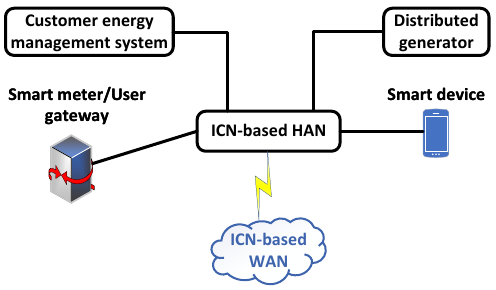
Figure 4. General structure of ICN.